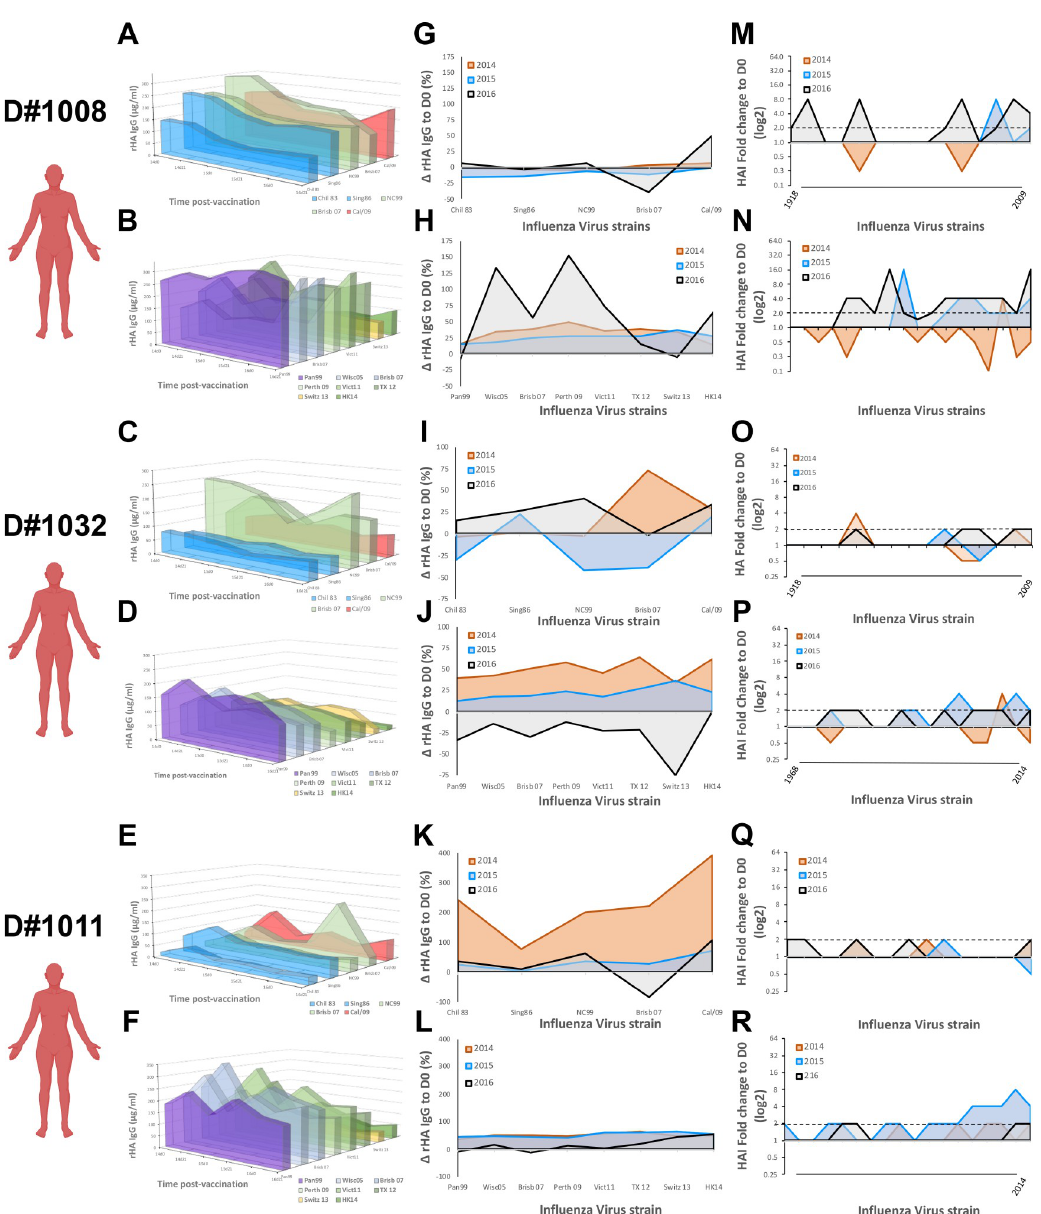
Fig 4. Serological antibody landscape in young participants vaccinated for three consecutive years. A,C,E) Serological IgG antibodies against rHA from current H1N1 vaccine strain and 4 historical seasonal H1N1 virus strains (1983–2007) in three young participants vaccinated for three consecutive years. Colors represent antigenically similarity between H1 rHA. B,D,F) Serological IgG antibody levels against rHA the current H3N2 vaccine strains and 5 historical seasonal H3N2 virus strains (1999– 2011) in three young participants vaccinated for three consecutive years. Colors represent antigenically similarity between H3 rHA. G,I,K) Changes in serological antibody levels against rHA from different H1N1 virus strains, measured as in A, 21–28 days after vaccination in young participants vaccinated for three consecutive years. H,J,L) Changes in serological antibody levels against rHA from different H3N2 virus strains, measured as in B, 21–28 days after vaccination in young participants vaccinated for three consecutive years. M,O,Q) Changes in serological HAI activity titer against different H1N1 virus strains (1918–2009) 21– 28 days after vaccination in young participants vaccinated for three consecutive years. N,P,R) Changes in serological HAI activity titer against different H3N2 virus strains (1968–2016) 21–28 days after vaccination in young participants vaccinated for three consecutive years.